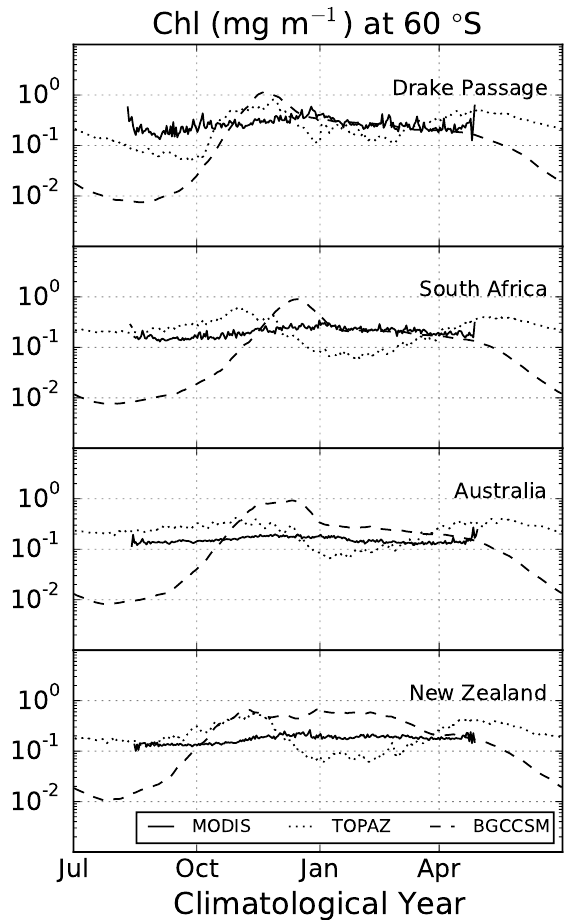
Figure 6. Detail of the Chl concentrations in mgm − 3 from Figs. 2– 5. The lines show a slice of each original panel at 60 ◦ S. All data that fall on a specific grid cell on a specific day of the year are averaged to one